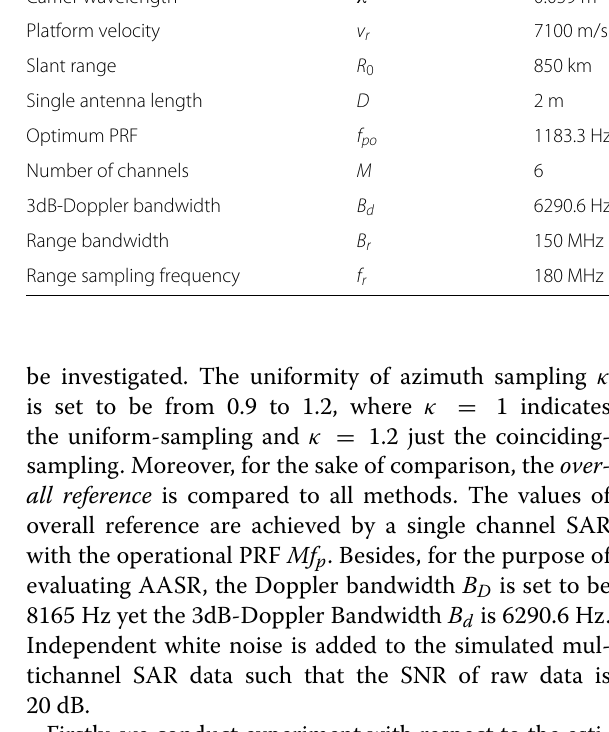
Table 1 Computation complexity of our adaptive reconstruction method Parameter dimension Operation Computation complexity